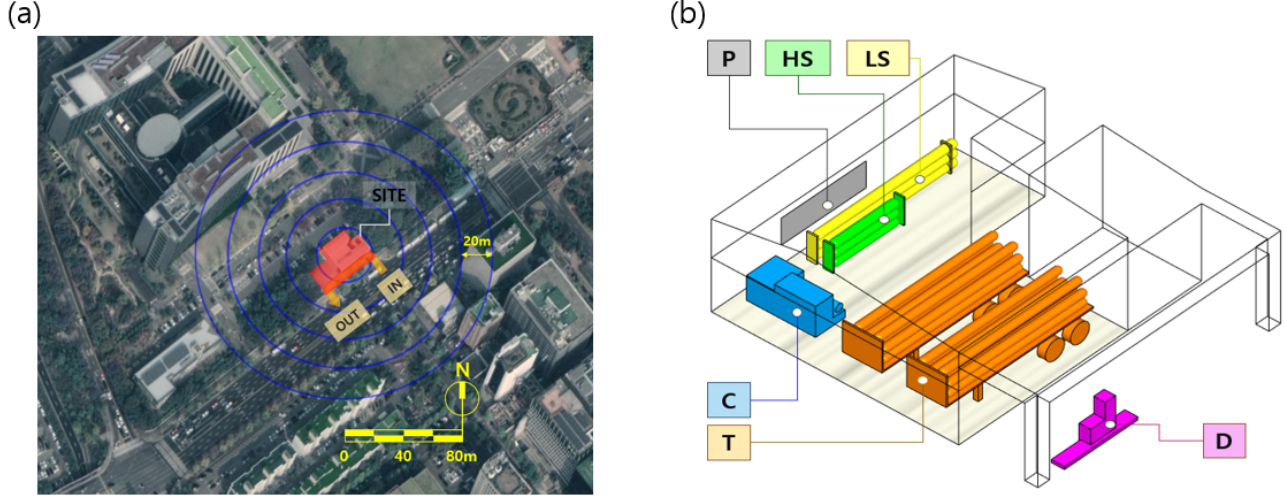
Figure 1. ( a ) Location of hydrogen refueling facilities and ( b ) schematic layout of the facilities of the hydrogen refueling station.